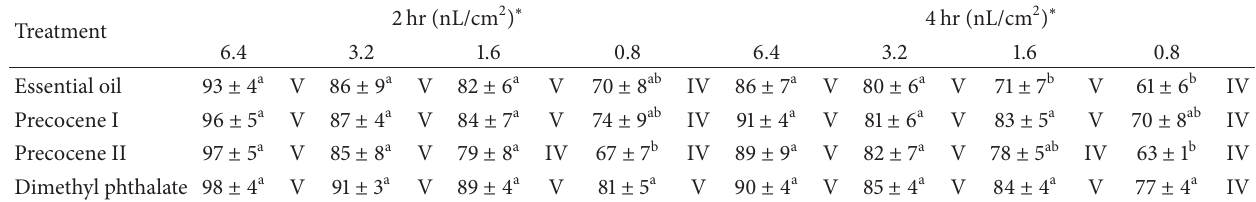
Table 4: Repellency (PR) after two exposure times for Ageratum houstonianum essential oil and its isolated compounds against Liposcelis bostrychophila